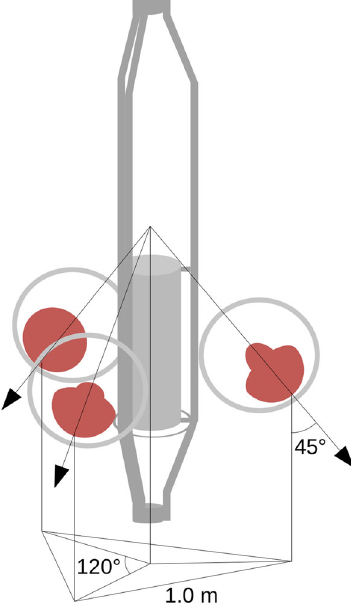
Fig. 1 Schematic representation of an ANTARES storey. The spheres standfortheOMs,whichcontainonePMTeach,facing45 ◦ downwards